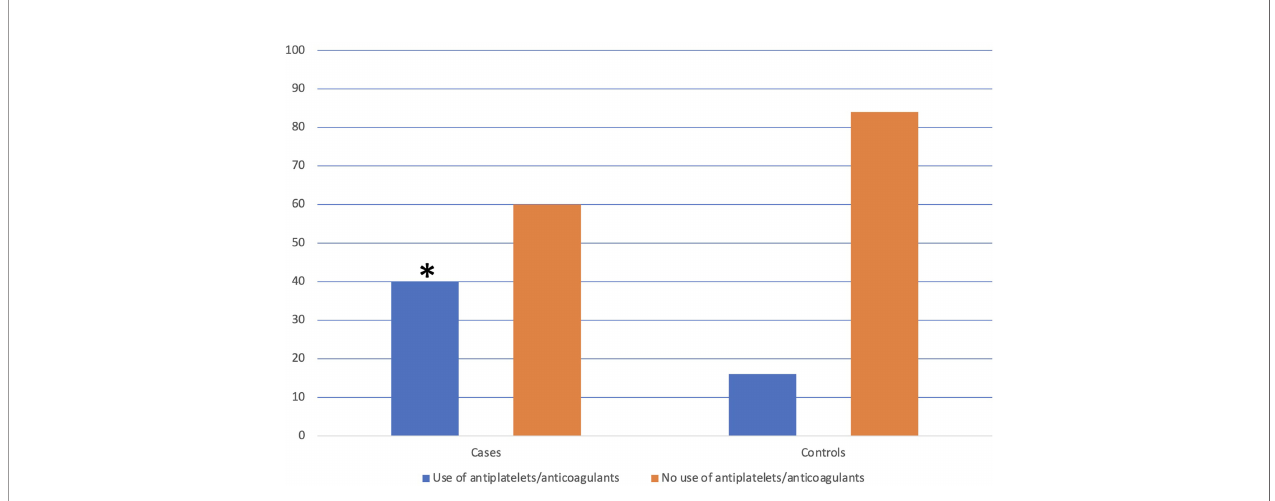
FIGURE 2 | Distribution of the use of antiplatelets/anticoagulants in patients with and without the development of gastric neoplastic lesions. *The use of antiplatelets/ anticoagulants was signi fi cantly more frequent in cases than in controls (40.0% vs. 15.7%,